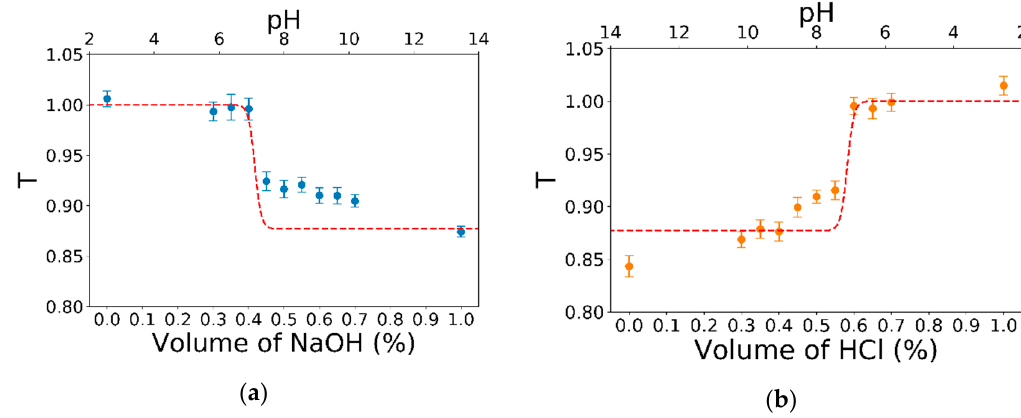
Figure 9. Comparison between the optical transmission responses obtained with the waveguide and the spectrophotometer analysis for the HCl neutralization ( a ) and for the NaOH neutralization ( b ). The blue and orange points representing each 3 min of data acquisition are plotted against the concentration of neutralizing species in the bottom axis (i.e., NaOH for HCl neutralization and HCl for the NaOH one). The red dashed lines, representing the prediction obtained from fits in Figure 6b by Equation (2) with l = 200 µ m, are plotted against the pH values in the top axis. The alignment between the two horizontal axes has been made considering the same center of the transition event.